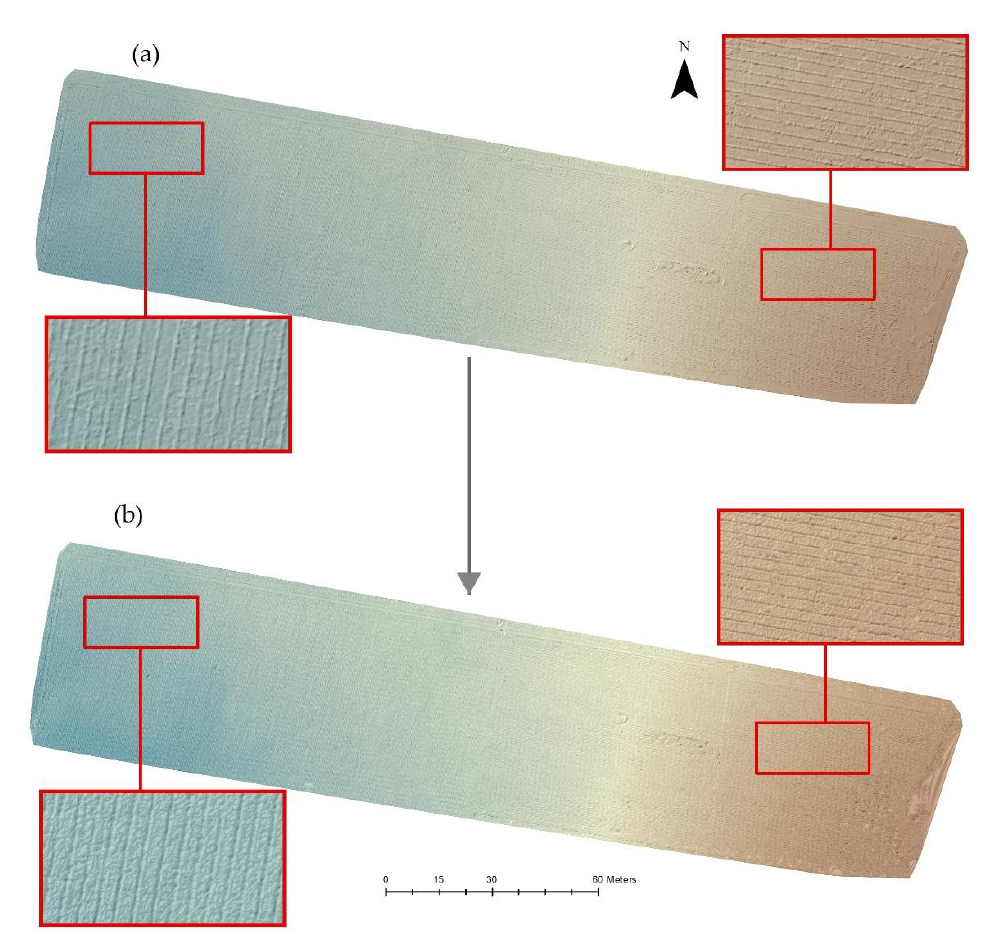
Figure 7. The process of DSM inversion. ( a ) DSM obtained after interpolating raw-DIPC; ( b ) IDSM obtained after inverting DSM. The plantation lines become more prominent in IDSM.